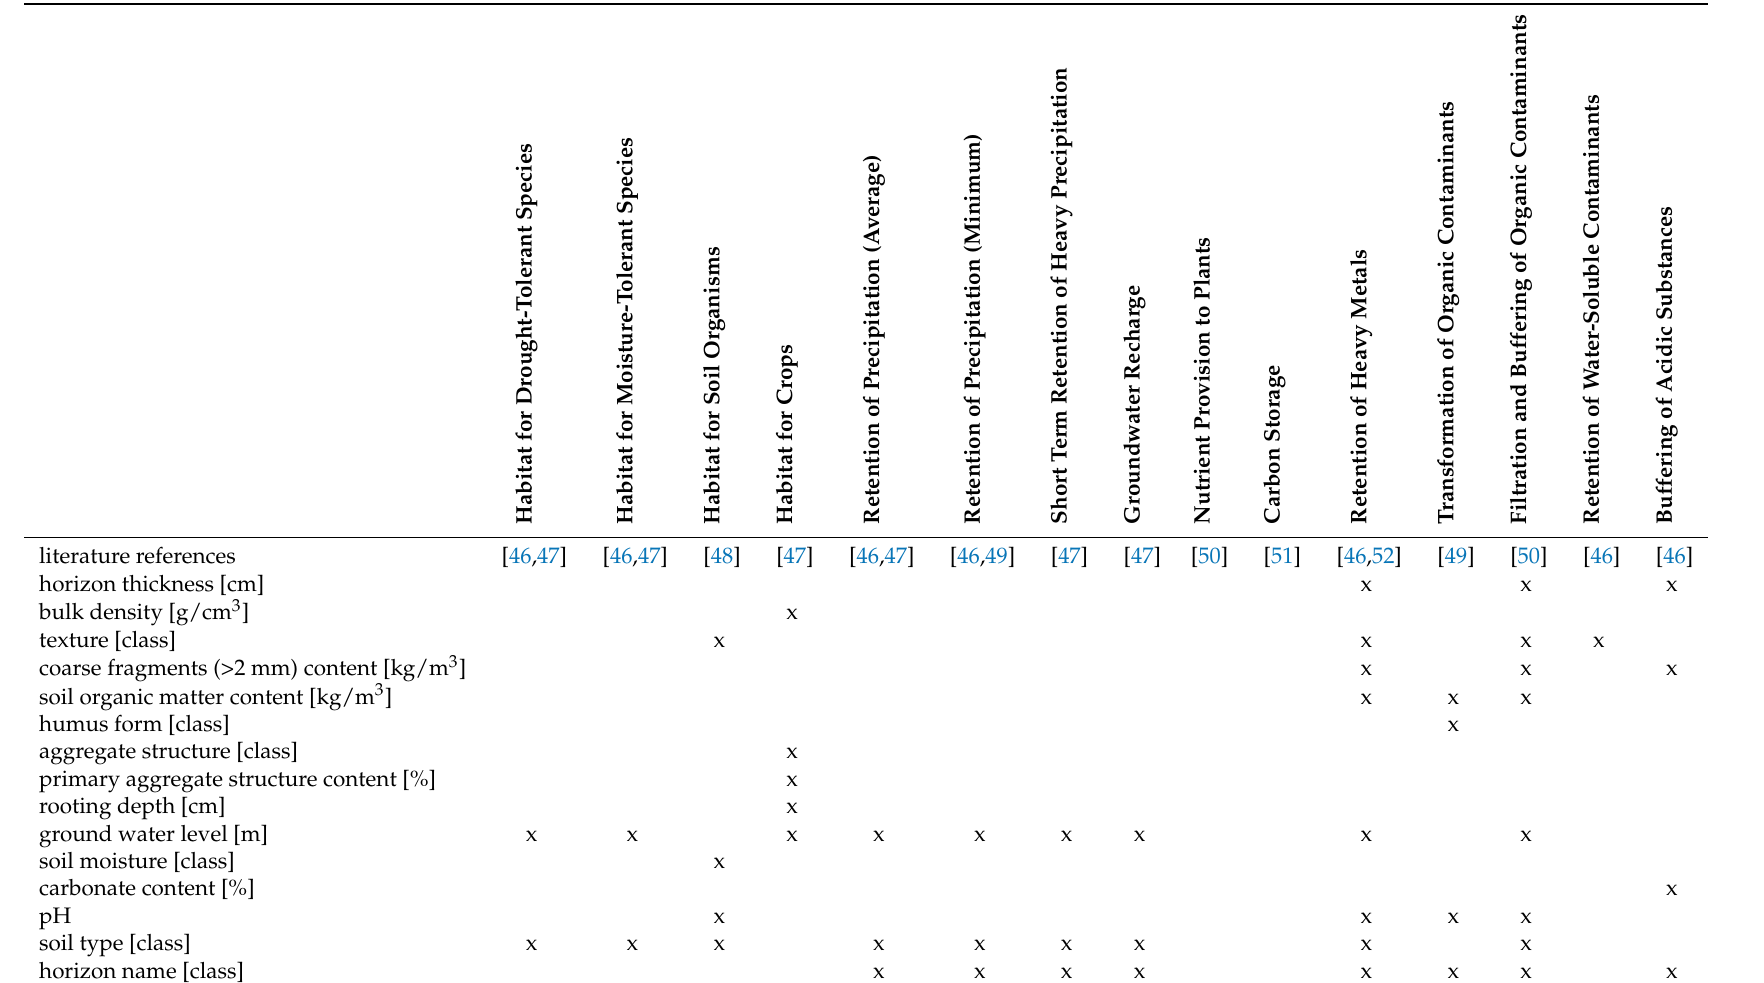
Table 3. Overview of the soil parameters and soil profile sum parameters (rows) which are used as input for calculating the fulfillment levels of the different soil functions